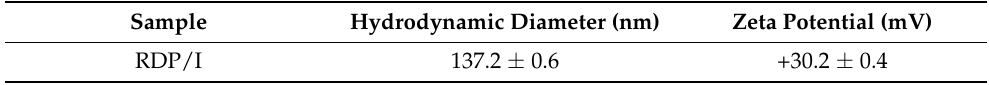
Table 2. Hydrodynamic diameter and zeta potential of RDP/I. Sample